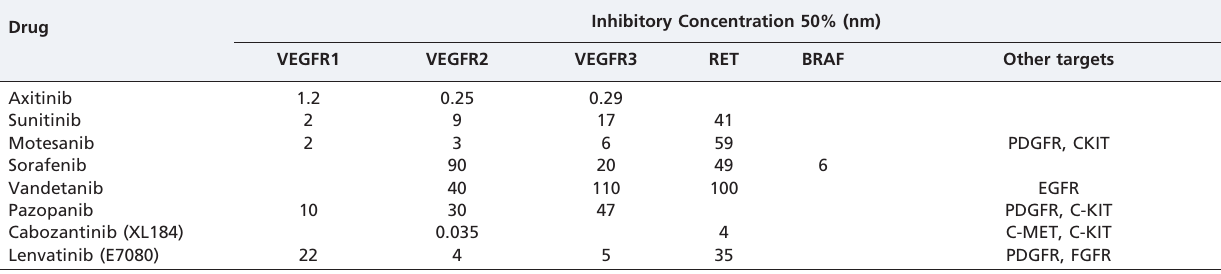
Table 1 - Kinase inhibitor activities relevant to thyroid carcinomas.